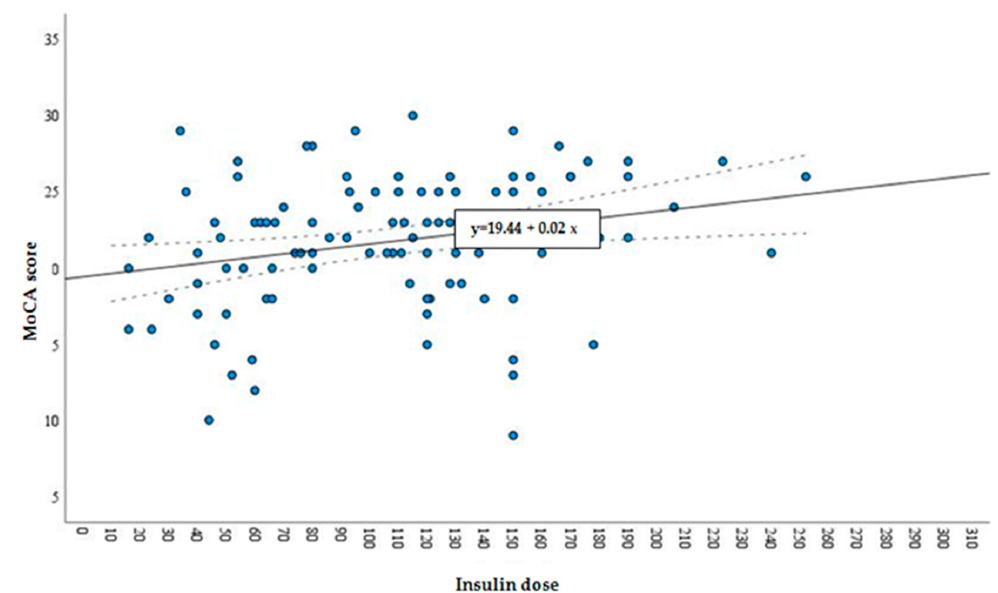
Figure 2. Linear correlation of insulin dose with MoCA score.